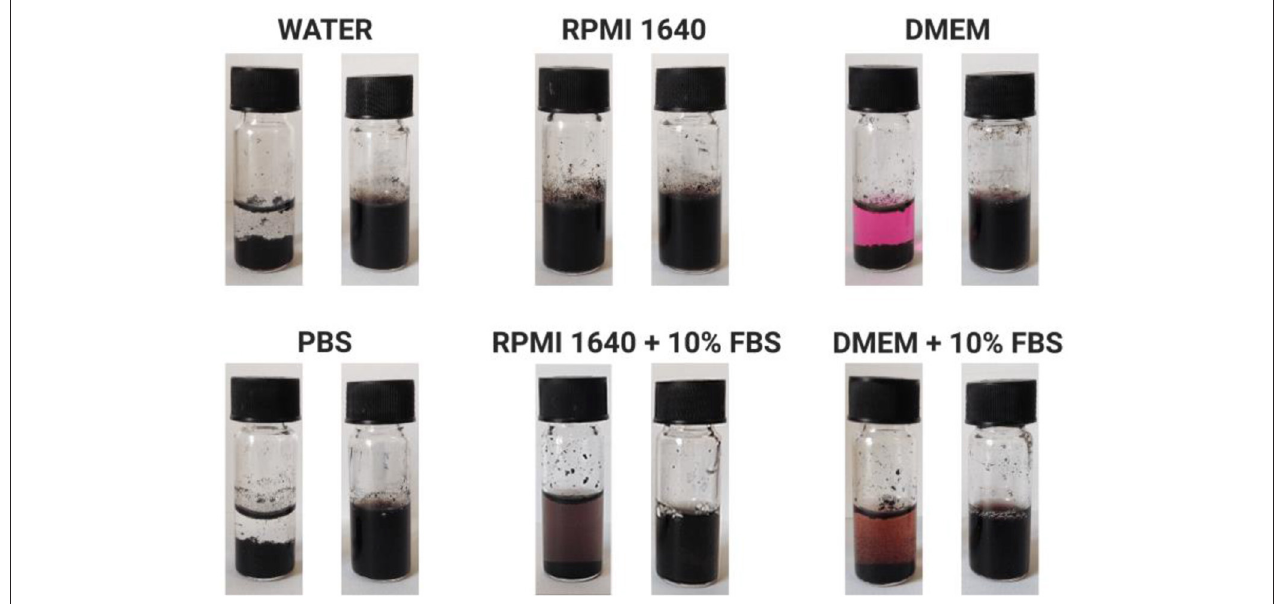
FIGURE 7 | Representative images of DOX/CNT (left) and DOX/CNT/HA-DMPE (right) dispersion stability after 3 months at 4 ◦ C in various biological fluids at a concentration of 500 µ g/mL. Representative images are of DOX/CNT/HA 200 -DMPE. Other HA MW showed similar results [data not shown].